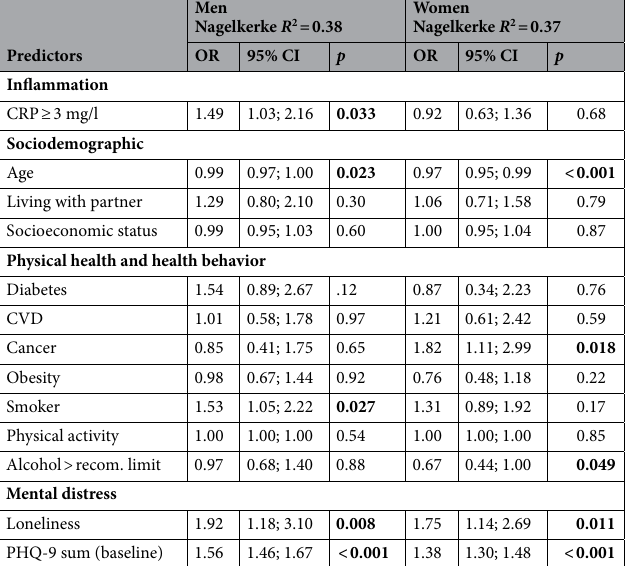
Table 3. Results of the logistic regression analysis: Prediction of new onset of depression at follow-up (based on predictors measured at baseline 5 years earlier, including CRP ≥ 3 mg/l), stratified by gender. Bold values indicate statistically significant predictors. CI confidence interval, CRP C-reactive protein, CVD cardiovascular disease, OR odds ratio, PHQ‑9 patient health questionnaire-9.